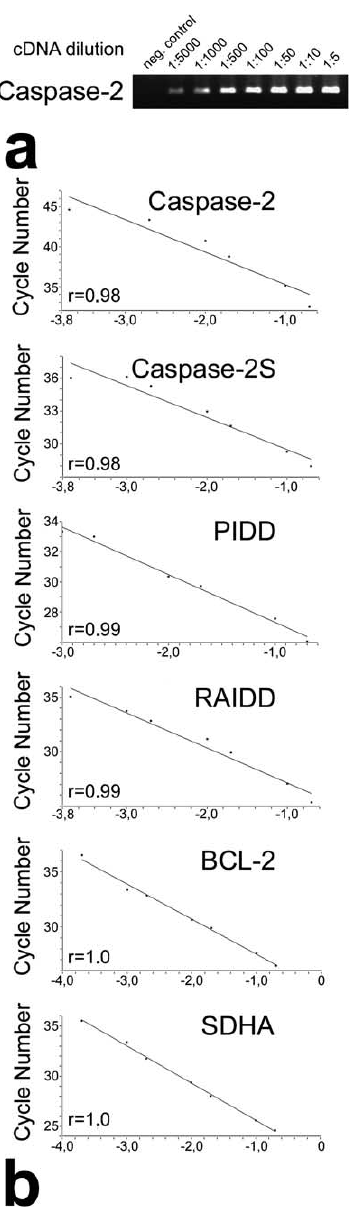
Fig. 1. Analysis of total caspase-2, caspase-2S, PIDD, RAIDD, BCL-2 and SDHA expression by real time PCR. (a) For a relative quantification, cDNAdilution series ranging from 1:1 to 1:5000 were used to create standard curves for total caspase-2, caspase-2S, PIDD, RAIDD, BCL-2 and SDHA for LightCycler PCR. Exemplarily, the agarose gel of the PCR for the total caspase-2 standard curve is shown. (b) LightCycler based standard curves for total caspase-2, caspase-2S, PIDD, RAIDD, BCL-2 and SDHA derived from PCR using the serial dilution series as template. The cycle number was plotted against the log of concentration by the second derivative maximum method. A correlation coefficient of r > 0 . 97 indicated a precise log linear